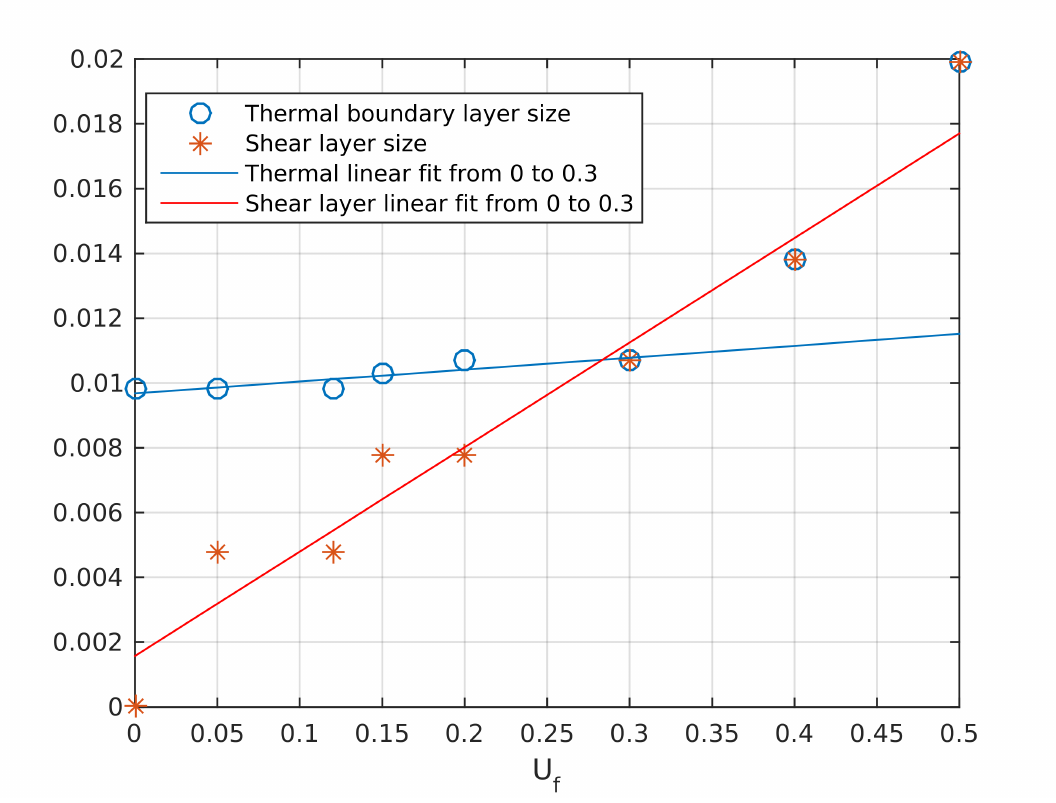
Figure 13. Thermal boundary and shear layers sizes (polar angle in radians) for various values of the velocity forcing U f